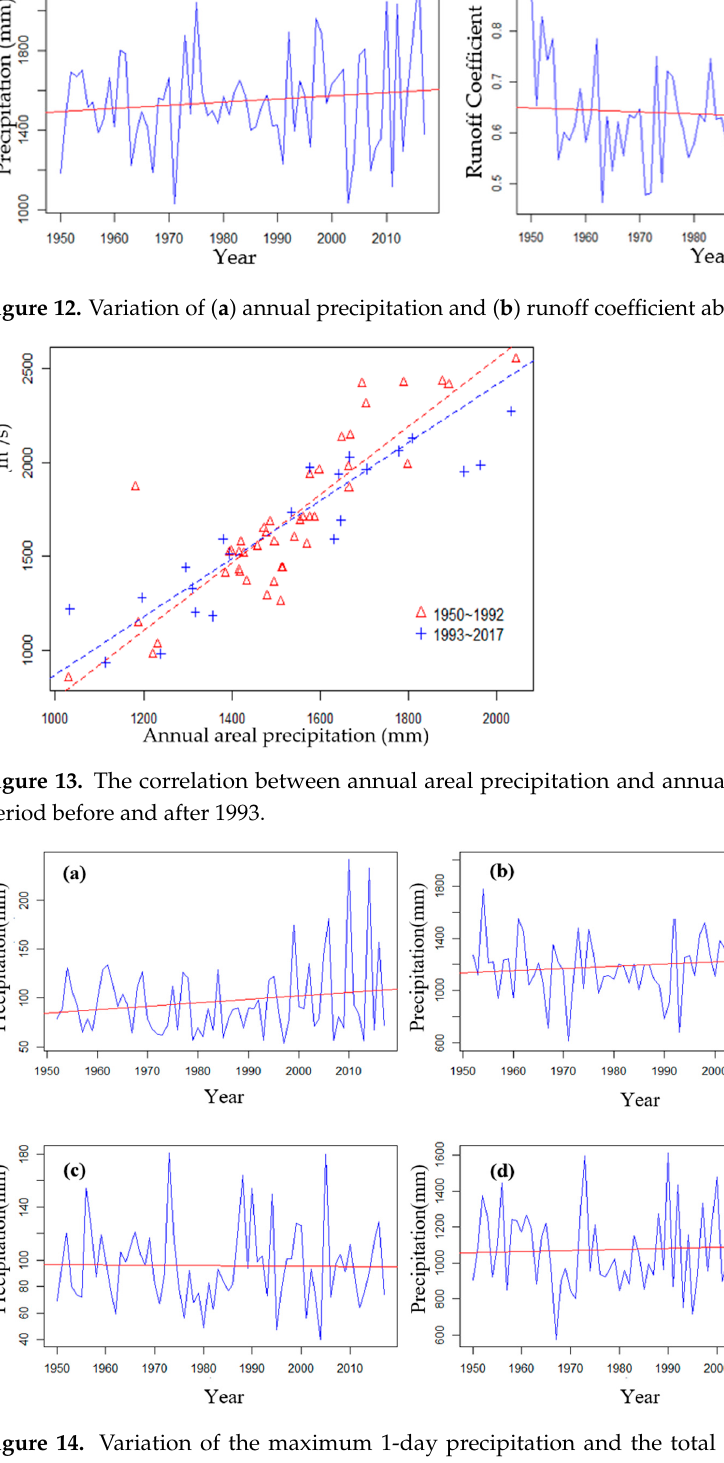
Figure 14. Variation of the maximum 1-day precipitation and the total erosive precipitation of Yangkou and Zhuqi. ( a ) Maximum 1-day precipitation of Yangkou, ( b ) total erosive precipitation of Yangkou, ( c ) maximum 1-day precipitation of Zhuqi, and ( d ) total erosive precipitation of Zhuqi.